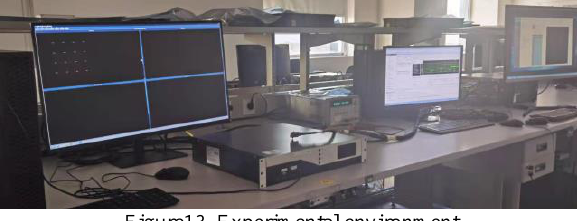
Figure13. Experimental environment Figure13 has shown the experimental environment of this system. The right was the image simulation, and the left was the image acquisition. The picture on the screen was the detection